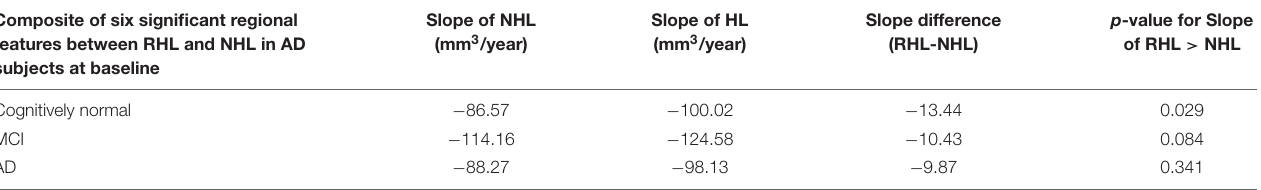
Slope of NHL Slope of HL Slope difference p -value for Slope (mm 3 /year) (mm 3 /year) (RHL-NHL) of RHL > NHL